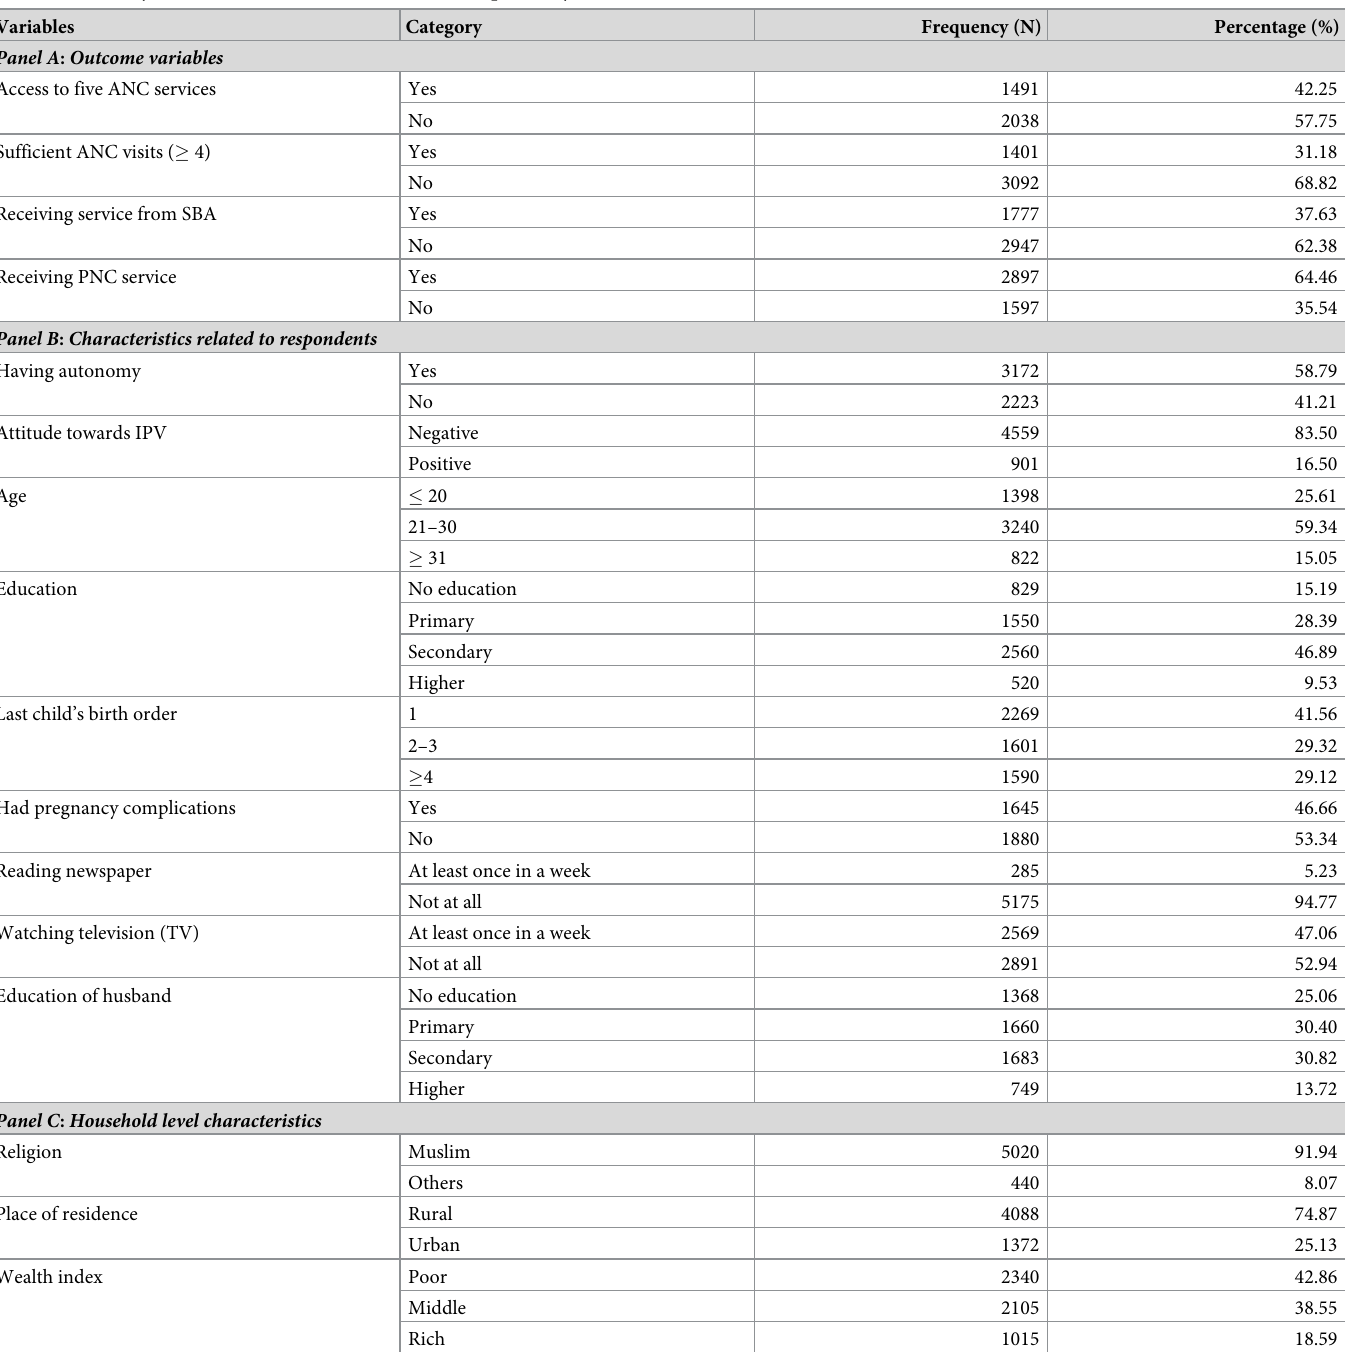
Table 1. Summary statistics of the outcome variables and explanatory